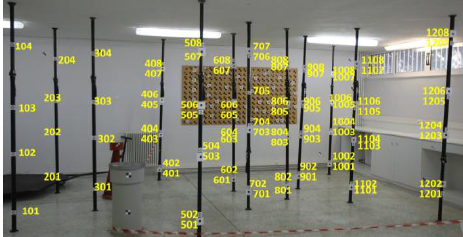
Figure 4: The Calibration Test Field of the Metrology Center